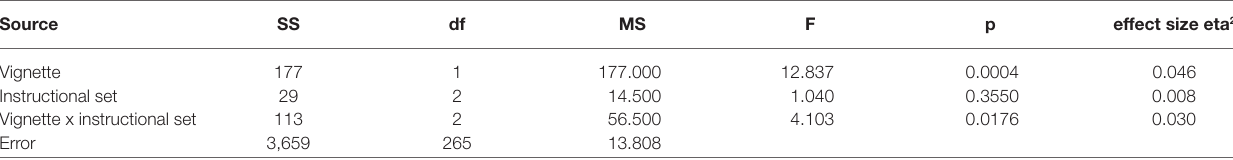
TABLE 2 | Results of the 2 × 3 factorial ANOVA for mean competence scores. Source SS df